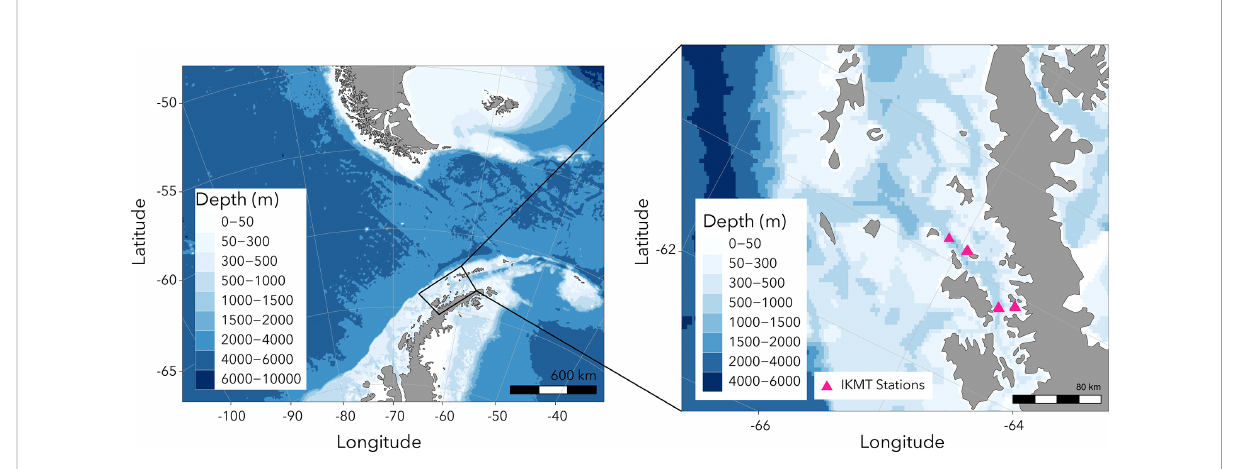
FIGURE 1 Map showing region where juvenile Antarctic krill were collected using the Isaacs-Kidd Midwater Trawl